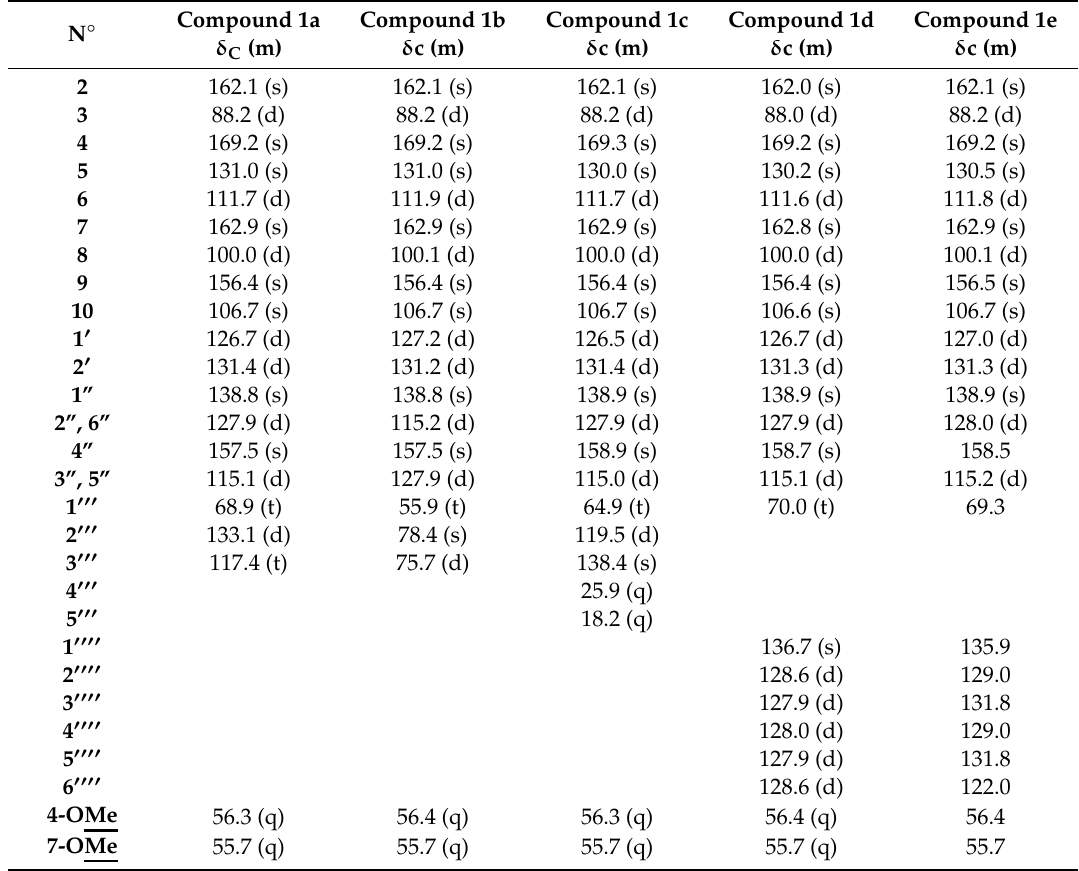
Table 3. 13 C NMR data of compounds 1a – e [CDCl 3 ; 125